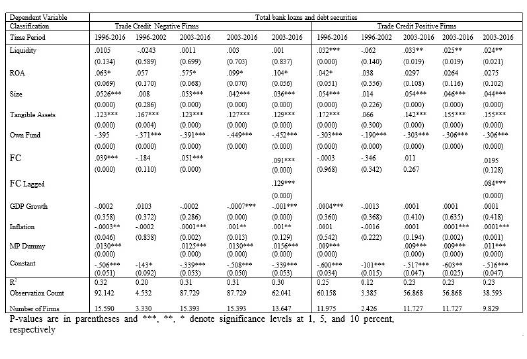
Table 6: Fixed Effect Analysis on Financial Debt- Based on TC